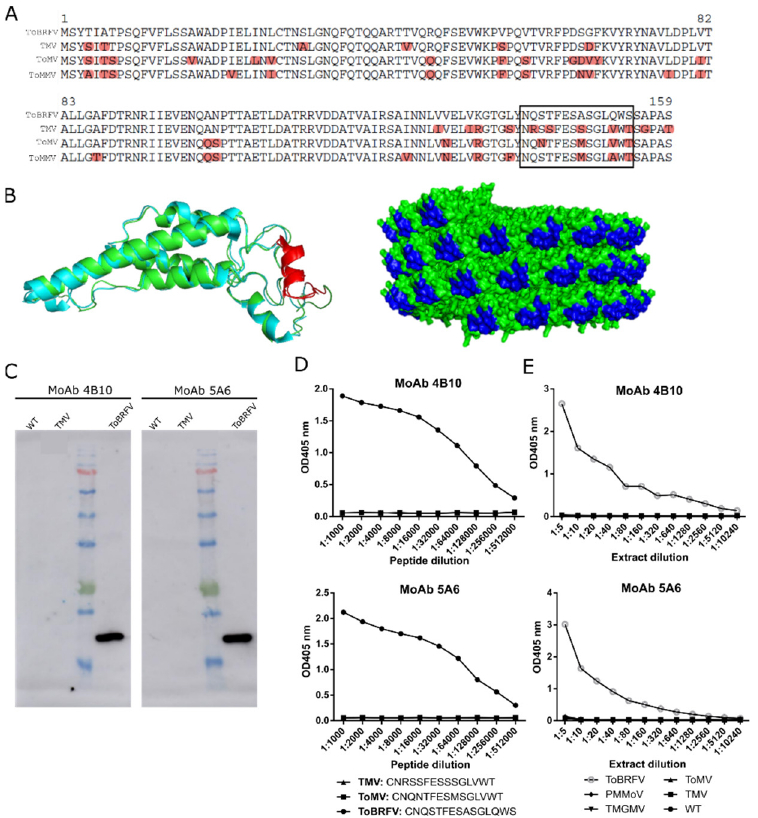
Figure 2. Design and evaluation of two monoclonal antibodies (MoAb 4B10 and MoAb 5A6) against ToBRFV CP. ( A ) Clustal alignment of the CP polypeptide sequences from ToBRFV (NC_028478), TMV (NC_001367), ToMV (NC_002692), and ToMMV (NC_022230) for the identification of a ToBRFV peptide candidate to give rise to specific ToBRFV antibodies (squared is the best candidate). ( B ) On the left, ribbon representation of the structural superposition of the TMV (blue) and the predicted ToBRFV CPs (green). The selected peptide is highlighted in red. On the right, molecular surface representation of the assembled virion particle of TMV with the selected peptide marked in blue. The TMV CP structure was obtained from the protein data bank (2om3, [33]) and the ToBRFV CP sequence from Uniprot (A0A0S2SZX3, [34]). Protein structure visualization was performed with Pymol. ( C ) Western blot analyzing the exclusivity of MoAb 4B10 and MoAb 5A6. Extracts from healthy (WT), TMV- and ToBRFV-infected plants were loaded. ( D ) Indirect ELISA results showing the exclusivity of MoAb4B10 or 5A6 when using serial dilutions of synthetic peptides (squared in (A)) for ToBRFV, ToMV, and TMV. ( E ) Analytical sensitivity and exclusivity of the DAS-ELISA tests devised with the monoclonal antibodies. Each data point represents a single measurement.